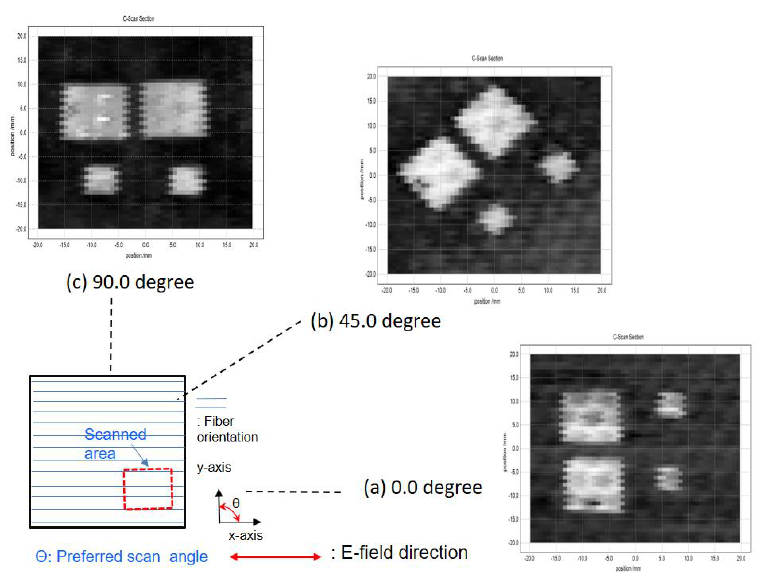
Figure 8. Terahertz scan images of glass-skin honeycomb sandwich composite panels with boned and brass foils (12.5 × 12.5 mm and 6.3 × 6.3 mm) at the bottom under time—domain spectroscopy (TDS) reflection mode.